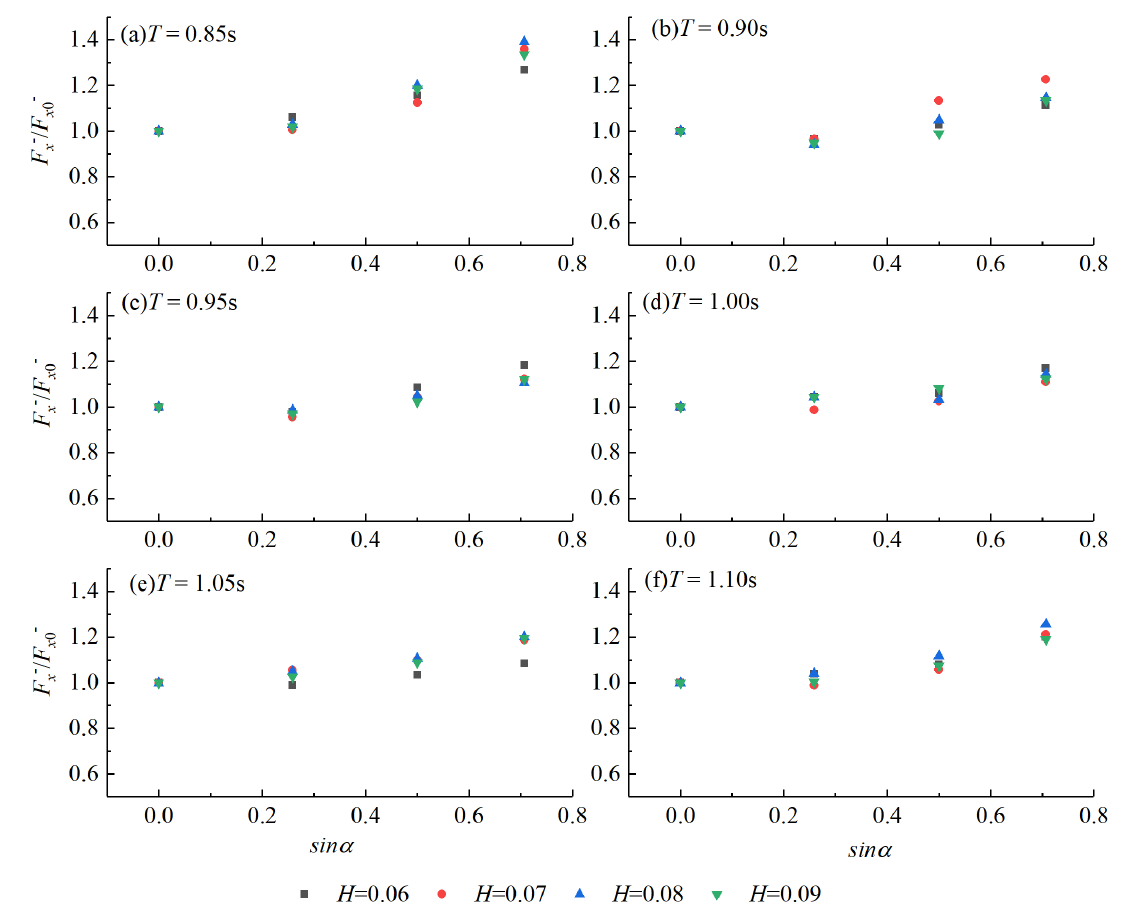
Figure 11. The wave directionality effect on the longitudinal negative peak force for the conditions of ( a ) T = 0.85 s, ( b ) T = 0.90 s, ( c ) T = 0.95 s, ( d ) T = 1.00 s, ( e ) T = 1.05 s, ( f ) T = 1.10 s.